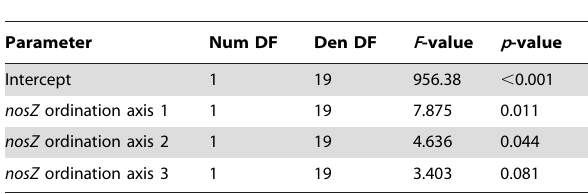
Table 2. Results from an ANOVA conducted to determine the significance of fixed effects on the final linear mixed-effects model (without interactions) of log-denitrification.